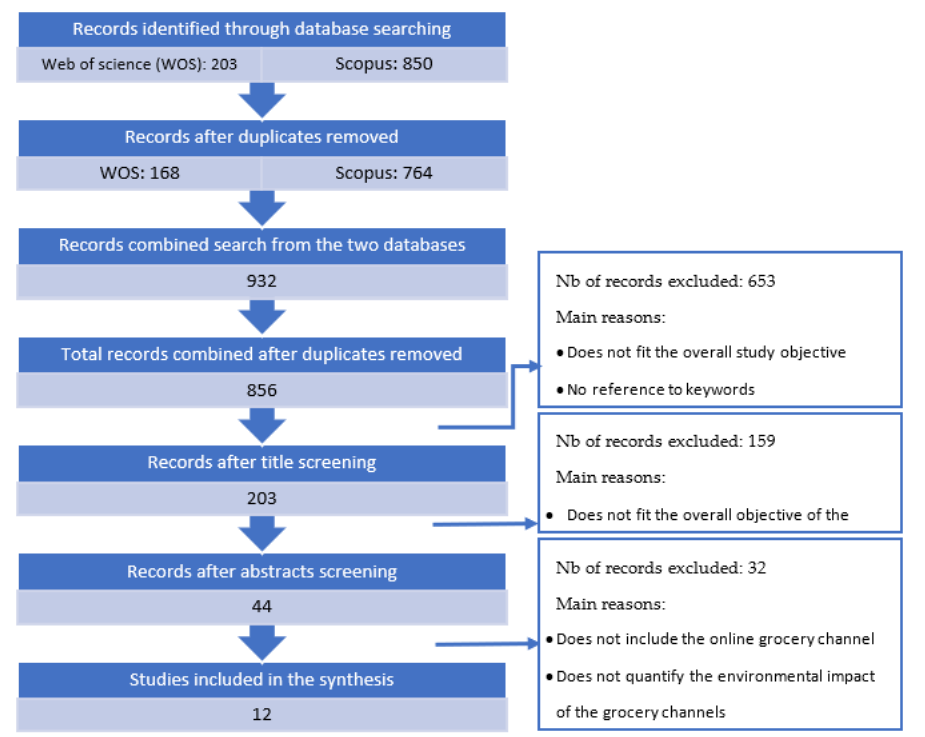
Figure 1. SLR methodology flowchart. Source: Adapted from PRISMA flowchart.